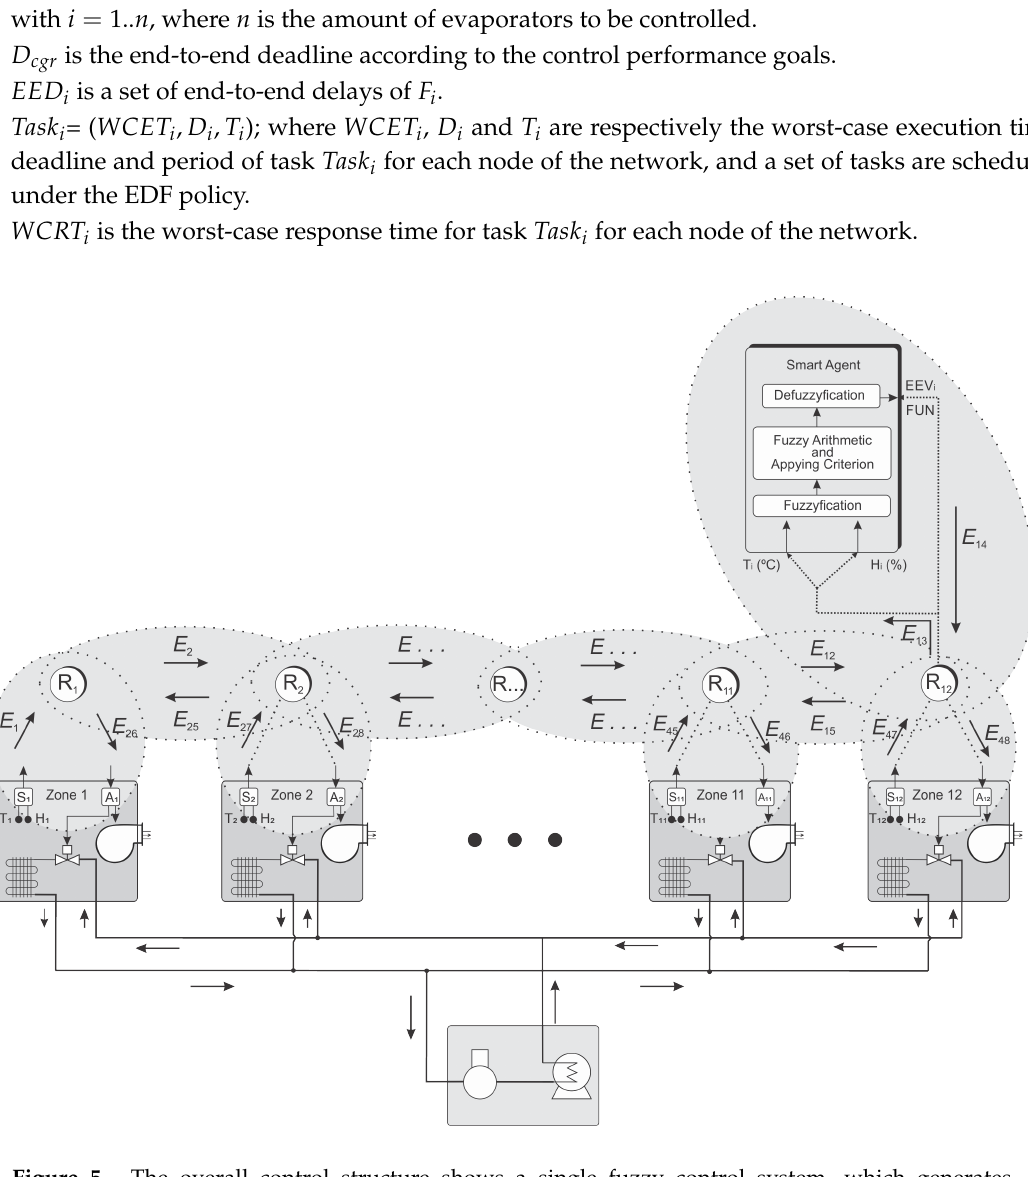
Figure 5. The overall control structure shows a single fuzzy control system, which generates temperature and humidity control actions through intermediate wireless nodes, delivering control actions to end nodes’